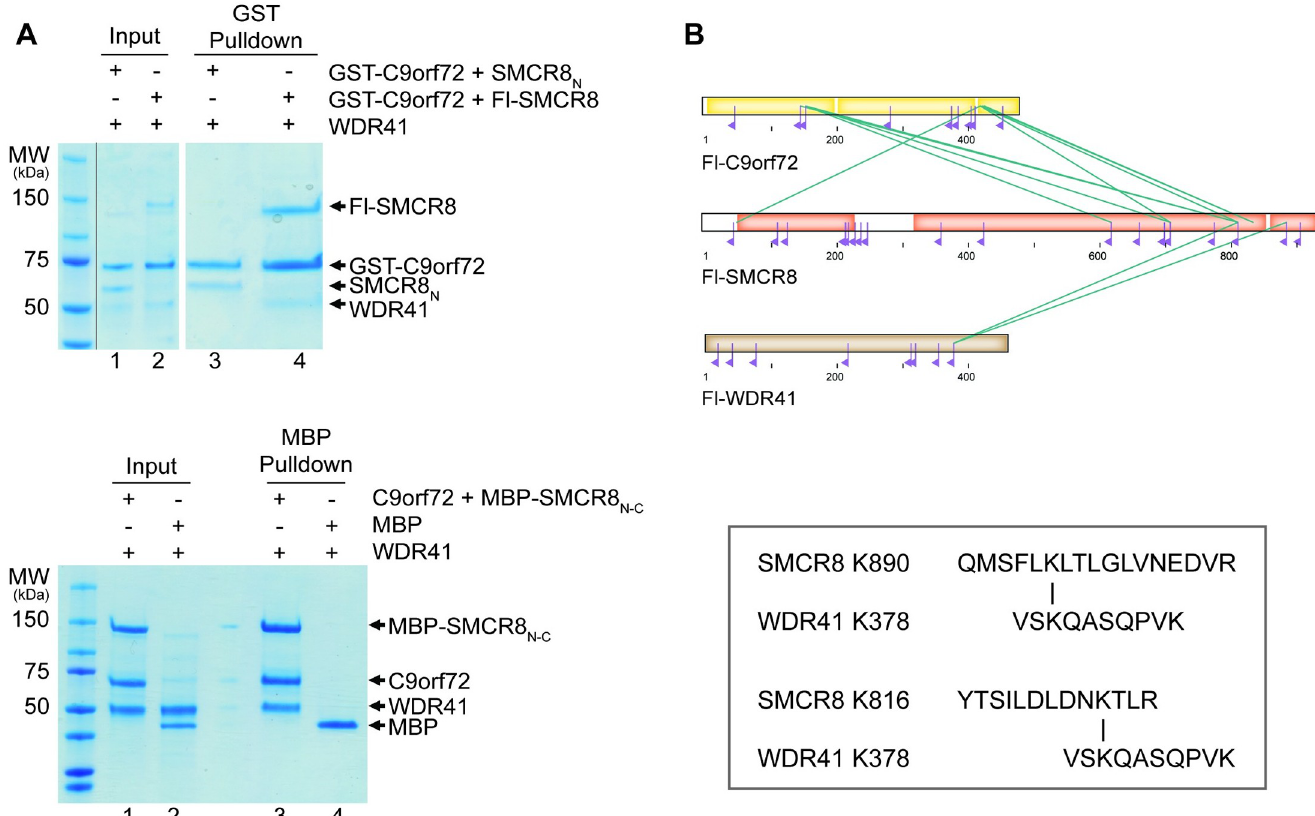
Fig 3. Interaction of C9orf72-SMCR8 N-C complex with WDR41. (A) Pull-down assay of purified WDR41 with the binary complex containing C9orf72 along with various constructs of SMCR8. The raw images can be found in S1 Raw Images. (B) Cross-linking of C9orf72-SMCR8-WDR41 ternary complex with DSSO and subsequent analysis of the cross-linked sample by mass spectrometry to identify cross-linked fragments. For clarity, only intermolecular cross-links are represented by green lines. Dead-end cross-linker–modified residues (Type 0 links [35] or monolinks) are shown as purple flags (top). The identified cross-linked fragments between the cDenn and dDenn domains of SMCR8 and WDR41 are displayed (bottom). cDenn, central Denn; Denn, differently expressed in normal and neoplastic cells; dDenn, downstream Denn; DSSO, disuccinimidyl sulfoxide; Fl,